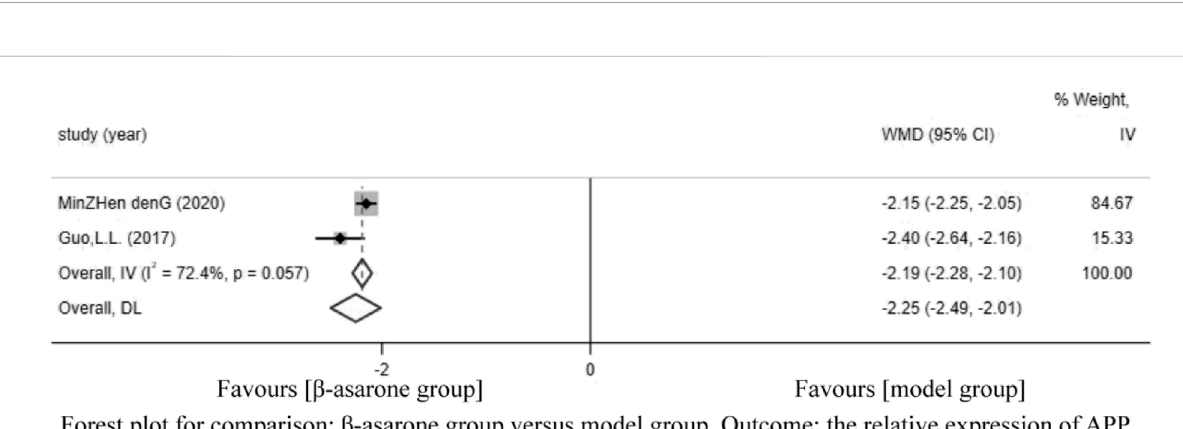
FIGURE 4 Forest plot for comparison: β -asarone group versus model group. Outcome: times of crossing platforms.